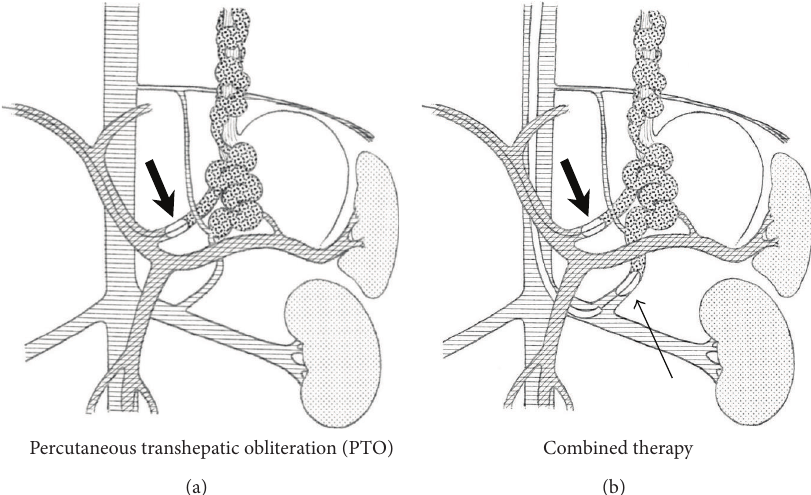
Figure1:Schemasofpercutaneoustranshepaticobliterationandcombinedtherapy.Percutaneoustranshepaticobliteration(PTO):inthecase of varices whose gastrorenal shunts were too underdeveloped for balloon occlusion, the PTO procedure was used. The intrahepatic portal vein is punctured from the right or left upper abdomen using a PTCD needle under ultrasonographic guidance. After an introducer sheath is inserted into the intrahepatic portal vein, a balloon catheter is inserted, and the catheter is advanced into the inflowing shunt vessel (mainly the left gastric vein), after which the balloon was inflated to occlude blood inflow (broad arrow). Combined therapy: the combined PTO and balloon-occluded retrograde transvenous obliteration (BRTO) procedure was used when the gastric varices had large shunt vessels (usually gastrorenal and left gastric vein shunts), which could not be successfully treated with either treatment alone. The narrow arrow indicates a balloon catheter placed in the gastro-renal